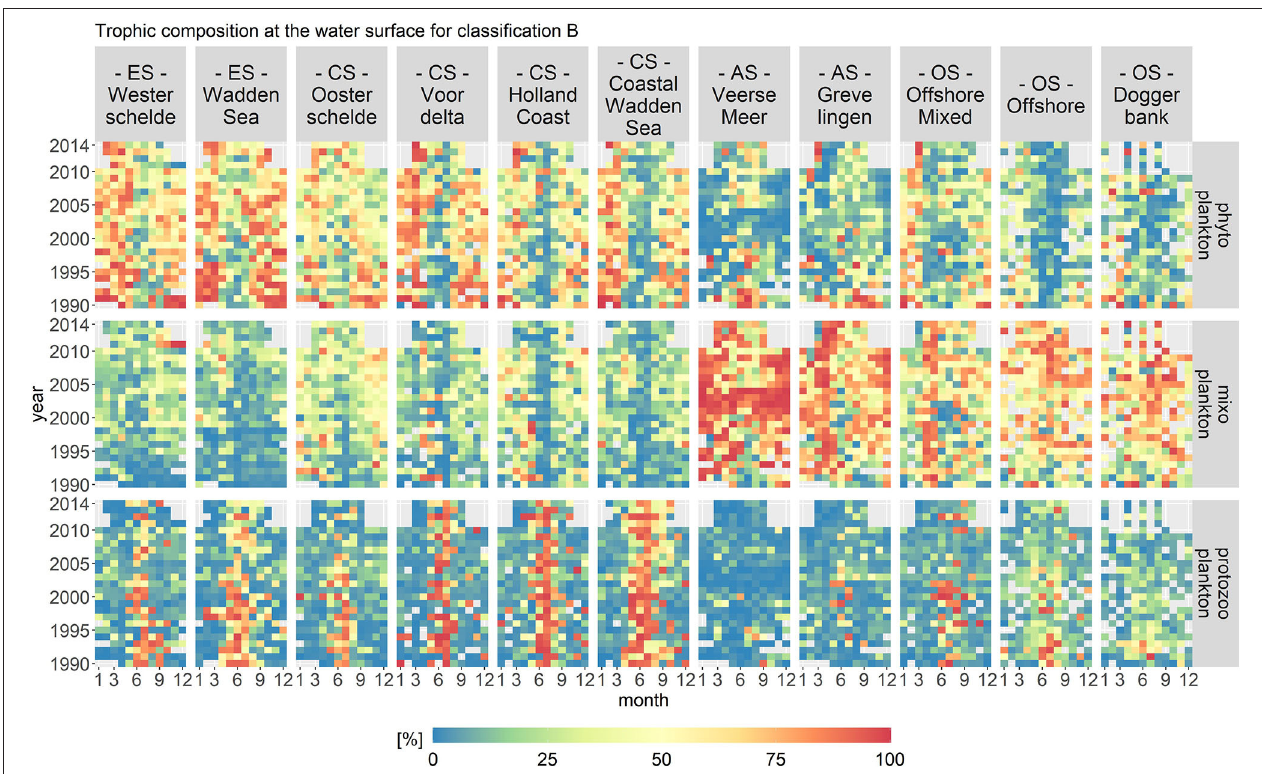
FIGURE 7 | Monthly fractions of the total biomass per trophic mode for trophic classification B. The location classes are grouped into estuary (ES), coastal (CS), anthropogenically modified (AS), and offshore systems (OS). The fraction of mixoplankton is highest in the offshore location class. All location classes display a seasonal occurrence of mixoplankton in the early summer and